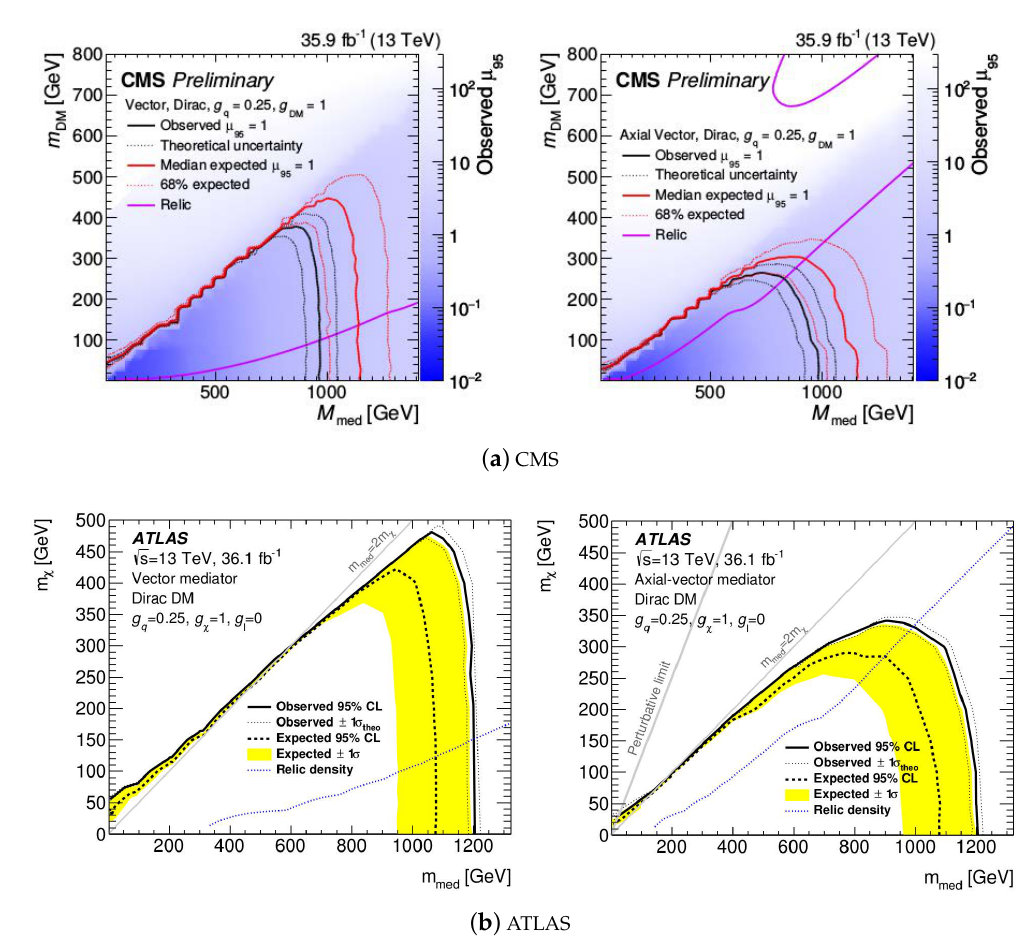
Figure 4. Exclusion limits for the CMS [9] ( a ) and ATLAS [10] ( b ) mono- γ analyses. On the left-side plots, results are interpreted in terms of the vector mediator, and on the right-side, plots in terms of the axial-vector mediator. In both cases, the DM particles are considered as Dirac fermions. The coupling of the mediator to quarks (g q ) is set to 0.25, and the coupling of the mediator to DM (g DM or g χ ) is fixed to